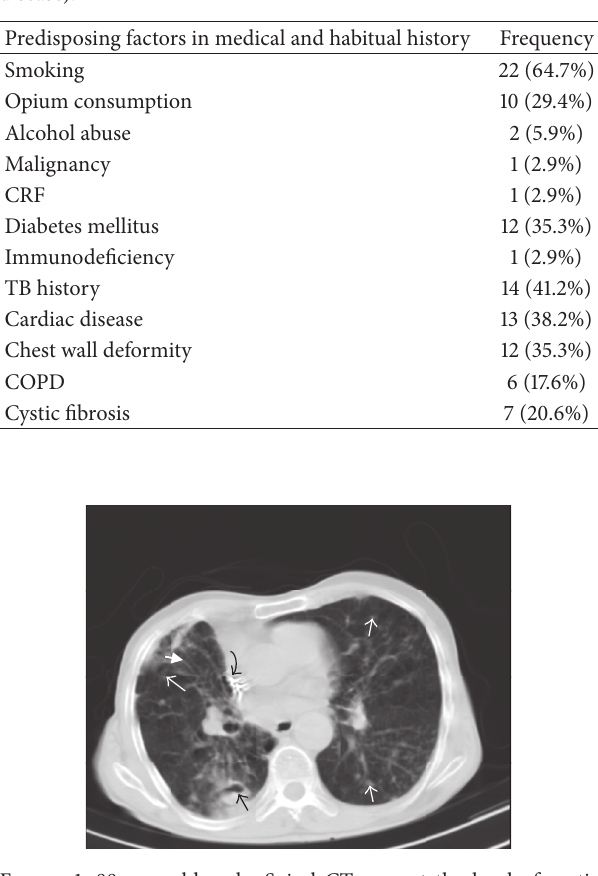
Table 1: Underlying conditions in medical and habitual history (CRF: chronic renal failure, COPD: chronic obstructive pulmonary disease).